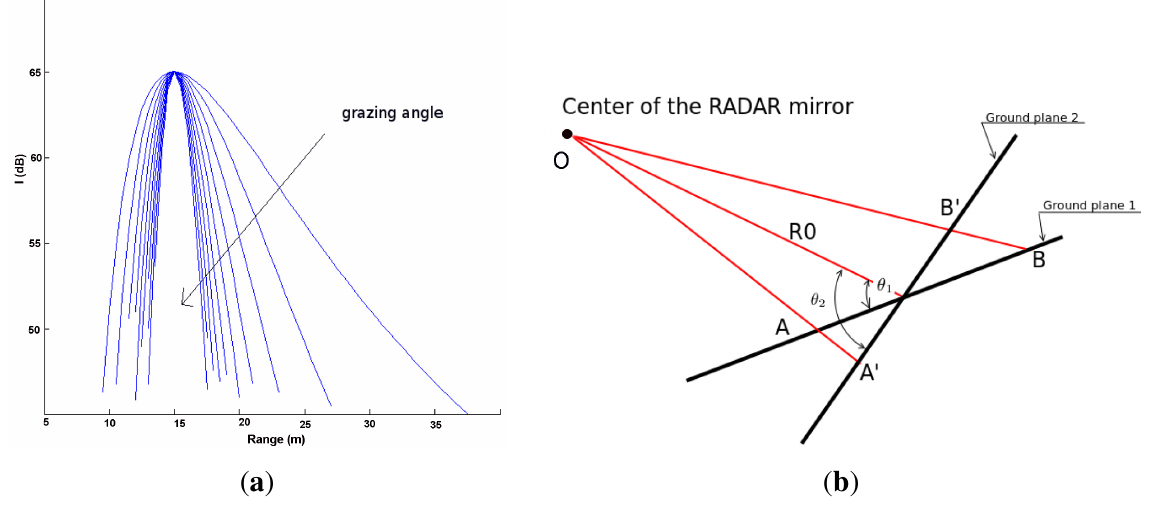
Figure 3. Change in the ground-echo model for increasing grazing angles, as indicated by the arrow in figure ( R range-spread as a function of θ